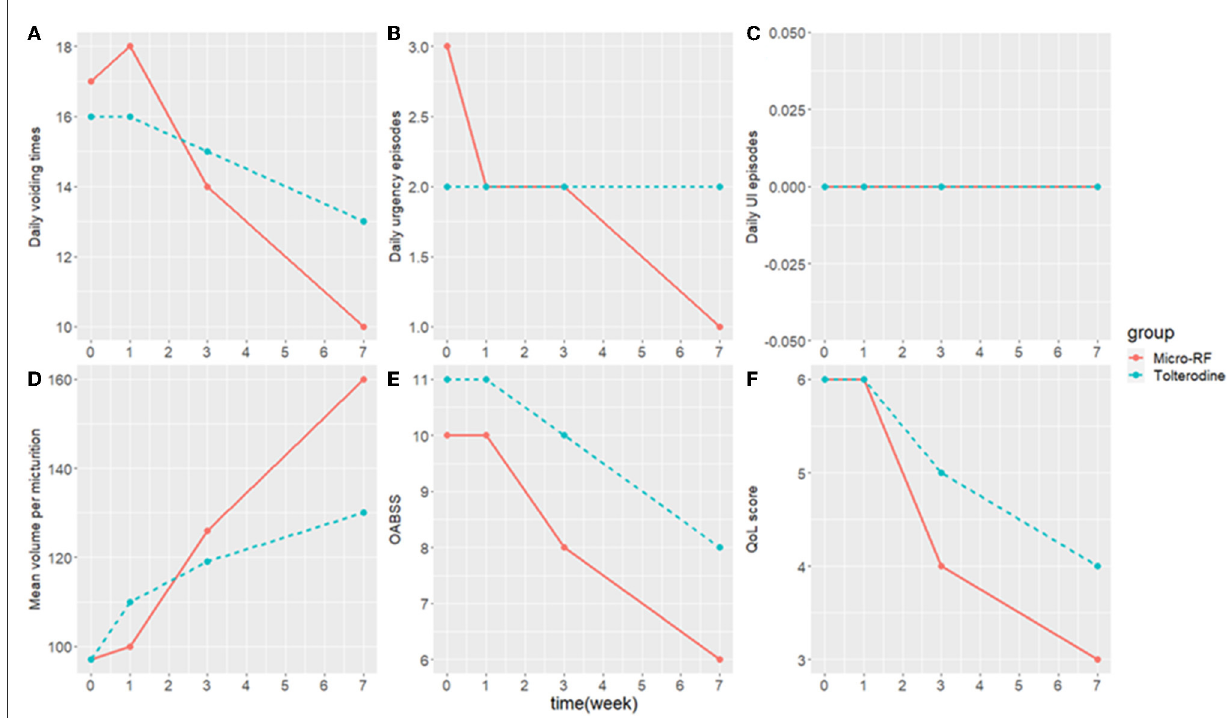
FIGURE2 The median of the clinical outcome from baseline through 1-, 3-, and 7-week follow-up visits. (A) Daily voiding times. (B) Daily urgency episodes. (C) Daily UI episodes. (D) Mean volume per micturition. (E) OABSS. (F) QoL score. OABSS, overactive bladder symptom score; QoL score, quality of life score; UI, urinary